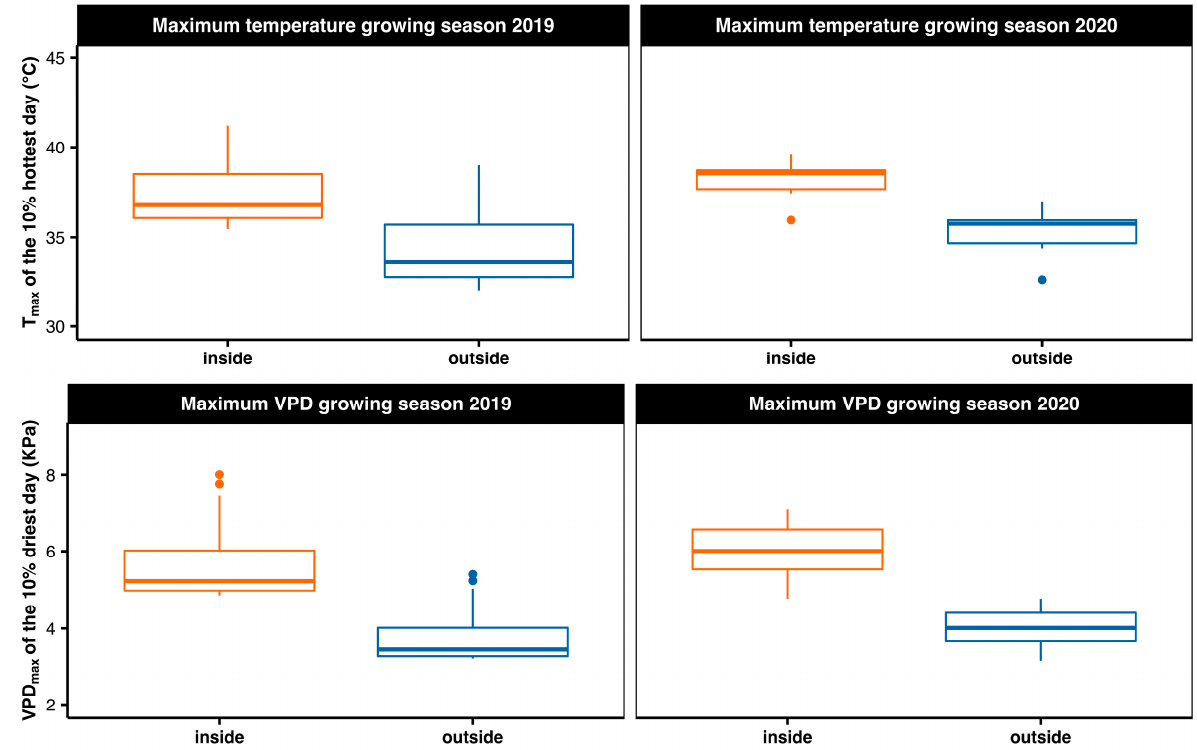
Figure 1. Boxplots showing the micro-climatic growing conditions in the greenhouse (inside) and open-field measurements at 2 m height (outside) during the growing season from May to September in 2019 and 2020. Given are the daily maximum temperature ( T max , ◦ C) for 10% of the hottest days as well as the daily maximum vapour pressure deficit (VPD max , kPa) for 10% of the driest days of each growing season. Please note that only the outside microclimatic data are available for both years, the inside values have been modelled based on data from 2021 (refer to Figures S1 and S2 for